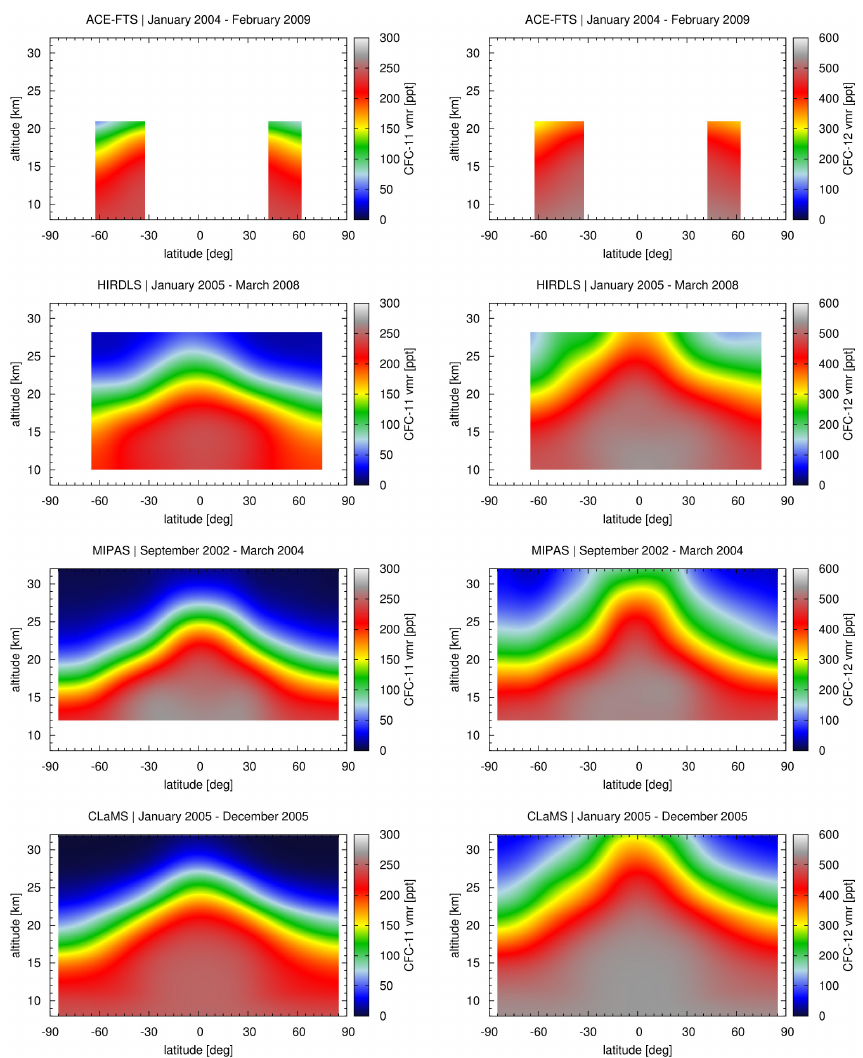
Figure 3. Zonal mean climatologies of CFC-11 (left) and CFC-12 (right) volume mixing ratios from the satellite experiments ACE-FTS, HIRDLS, and MIPAS, as well as the EMAC/CLaMS model. See plot titles for time periods covered by the different climatologies. Note that altitudes are log-pressure altitudes for the satellite climatologies and geopotential heights for the EMAC/CLaMS